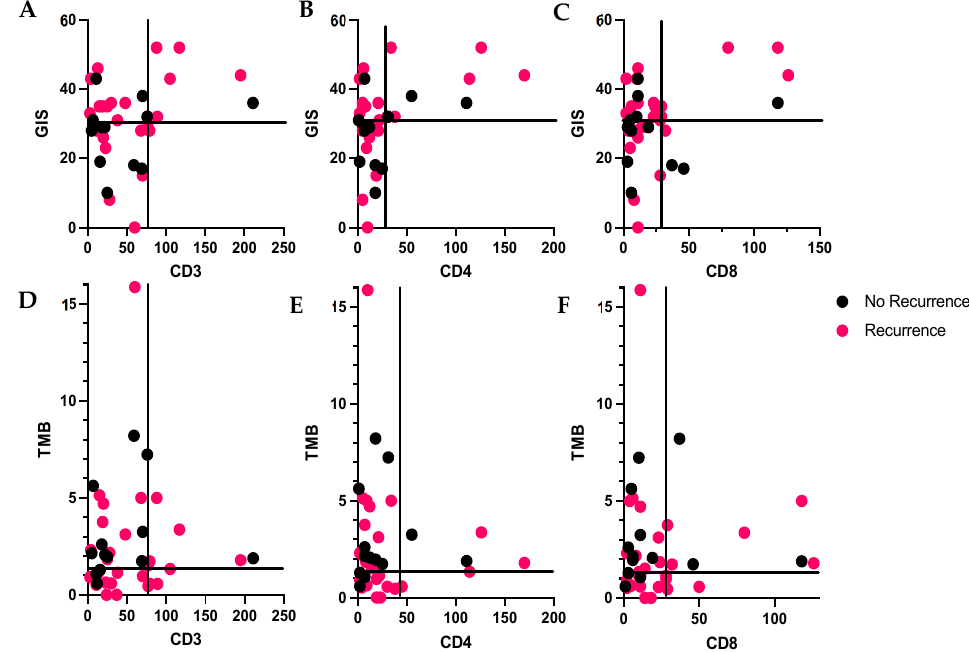
Figure 3. A – C: Distribution lymphocytes by genomic instability score (GIS) and tumor recurrence; pink = recurrent, black = no recurrence. Quadrants defined by GIS > 31 (median) or ≤ 31 and number of TILs > or ≤ the 75th percentile. D – F: Distribution lymphocytes by tumor mutational burden (TMB) and tumor recurrence. Quadrants defined by TMB > 1.35 (median) or ≤ 1.35 and number of TILs > or ≤ the 75th percentile. A : CD3+ lymphocytes, 75th percentile is 76.8, B : CD4+ lymphocytes, 75th percentile is 28.8, C : CD8+ lymphocytes, 75th percentile is 28.8.